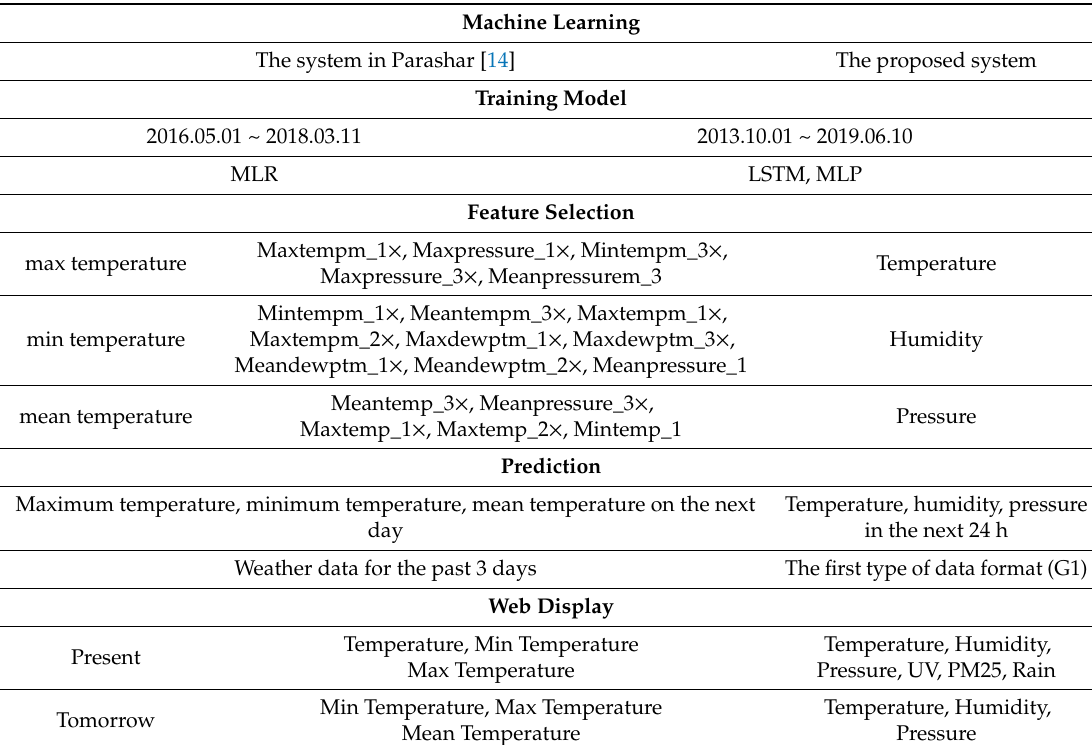
Table 11. Comparison table of training and prediction methods.